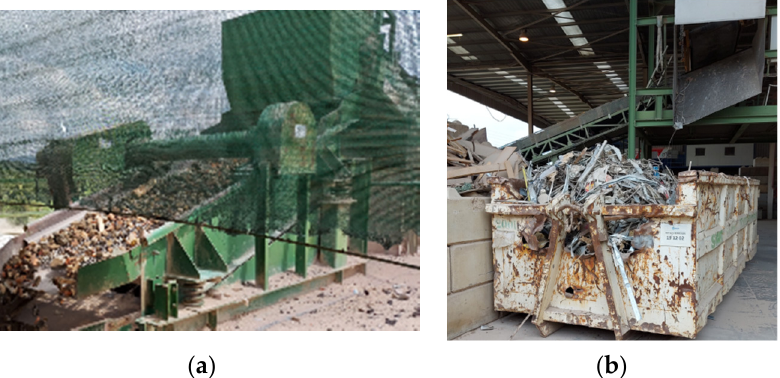
Figure 3. Crusher and magnetic separator( a ) Impact crusher ( b ) Magnetic separator